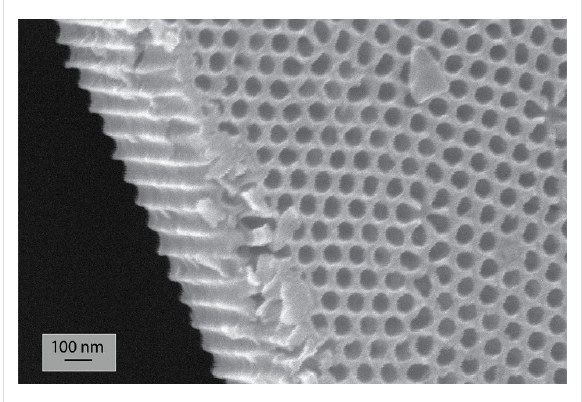
Figure 14: SEM micrograph of an anodic alumina oxide template. After the electropolishing, a sacrificial film was firstly grown by applying 40 V in 0.3 M H 2 C 2 O 4 for 24 h at T = 8 °C and then dissolved in